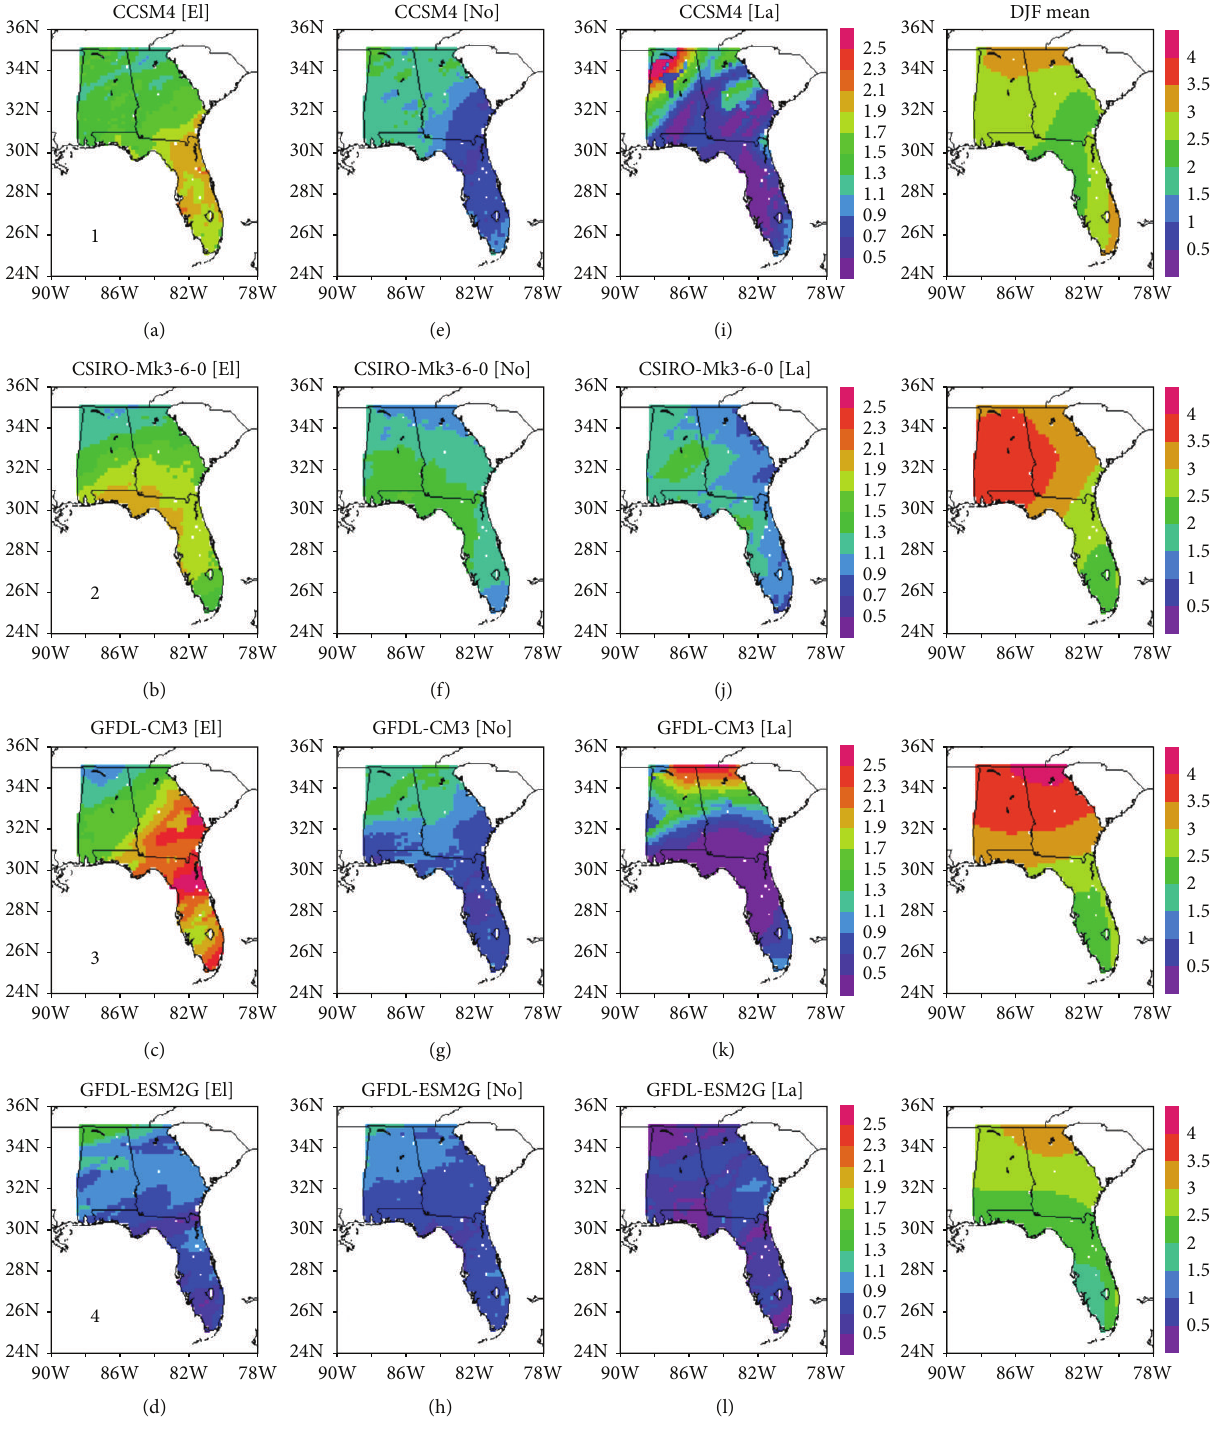
Figure 5: The 75th percentile of DJF mean daily precipitation anomalies (mm/day) distribution of El Ni˜no ((a)–(d)), neutral ((e)–(h)), and La Ni˜na ((i)–(l)) years in historical run of CMIP5 models 1–4. DJF mean daily precipitation is shown in the right